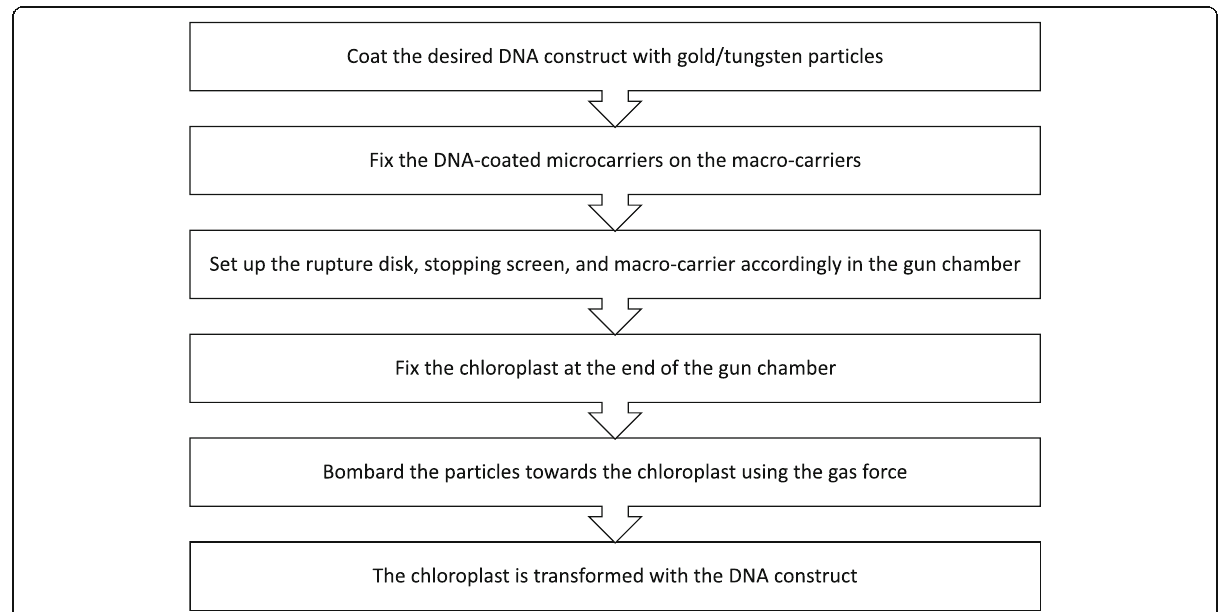
Fig. 2 Flow chart that summarizes the steps involved in biolistic